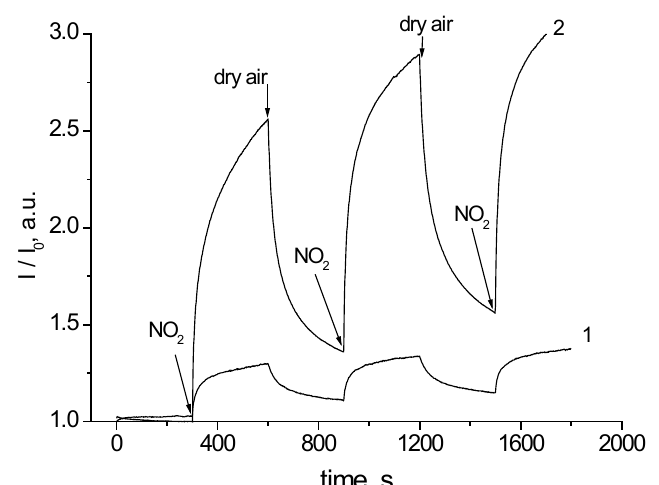
Figure 6. The response of SWCNT-PTMSP thin films to 100 ppm NO (synthesis